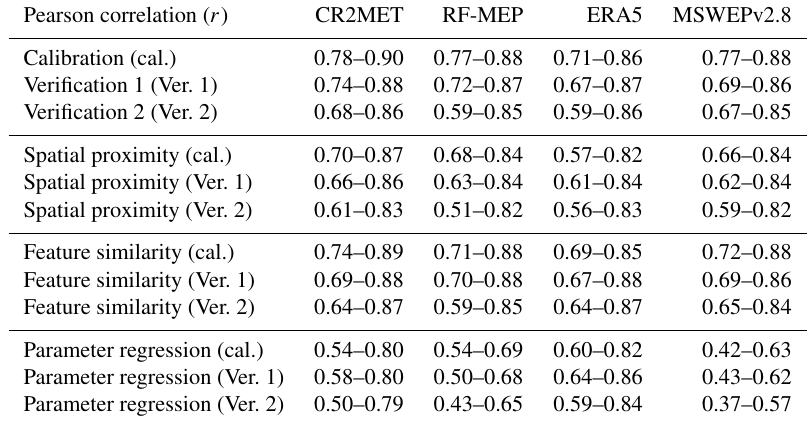
Table C1. Quantiles 0.25 and 0.75 of the correlation coefficient ( r ) of the KGE (cid:48) over the selected catchments. Pearson correlation ( r